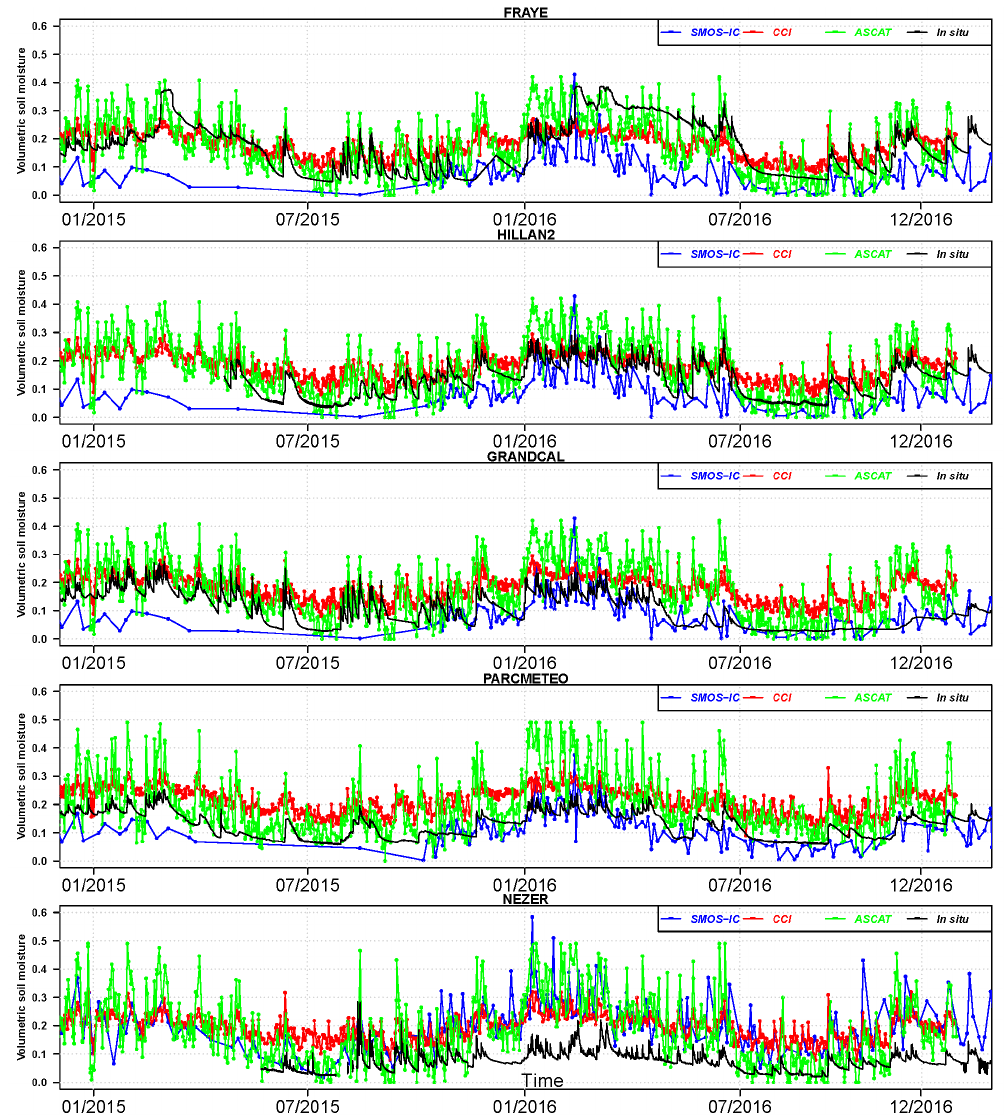
Figure 4 . Time series of SMOS-IC, ASCAT, CCI, and the Bouron, Nezer, and Parcmeteo in situ soil moisture observations.